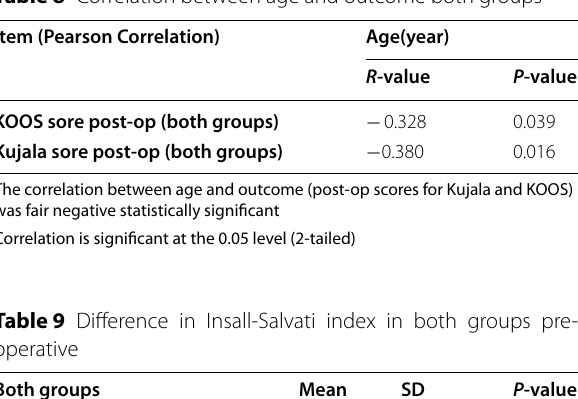
Table 8 Correlation between age and outcome both groups